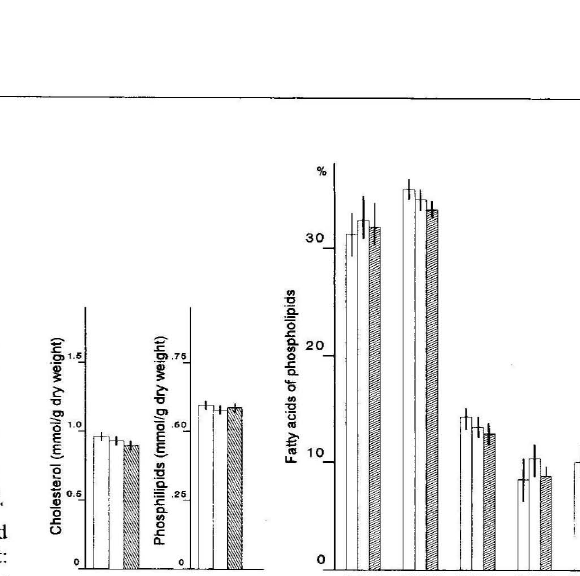
Figure 2. Concentrations (mean ± S.D.) of cholesterol and phospholipids, as well as fatty acid content (in percent: mean ± S.D.) of phospholipids in controls (open bars) and in samples with 5 pmollg wet weight (dotted bars) or with 30 pmol/g wet weight (hatched bars) 7,8-dihydrobiopterin. Samples of rat liver tissue homogenate were used to test for phospholipid biosynthesis in vitro. Incubation medium: krebs-Ringer-phosphate buffer (pH = 7.4), fatty acid mixture and glycerol. Samples were incubated twice for 4 h at 37°C.